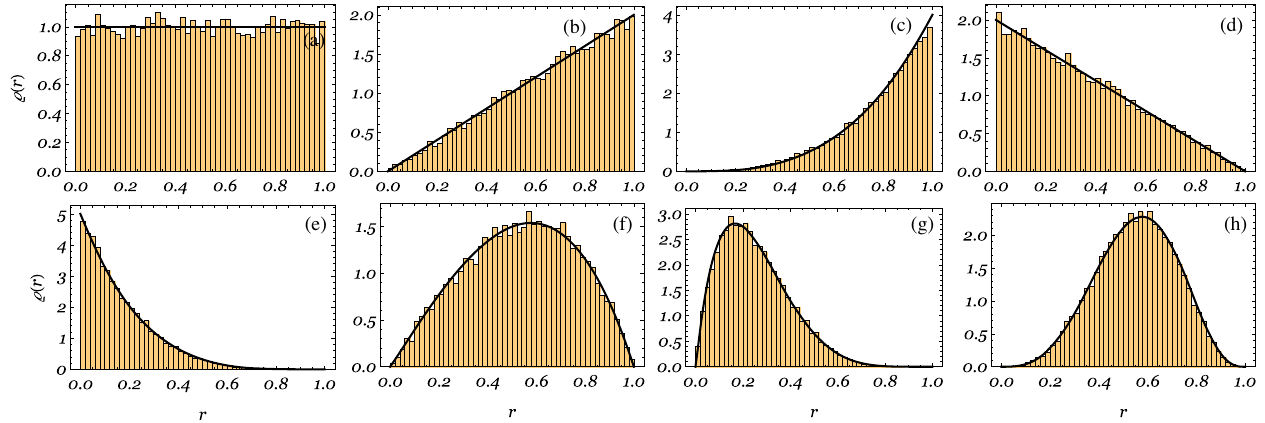
FIG. 12. Comparison of analytic prediction for the m NN by k NN spacing ratio, Eq. (A14), black line, with numerical results. Each histogram is obtained by computing the ratios for 20 000 IID levels. The numerical parameters are as follows: (a) d ¼ 1 , m ¼ 1 , k ¼ 2 ; (b) d ¼ 2 , m ¼ 1 , k ¼ 2 ; (c) d ¼ 4 , m ¼ 1 , k ¼ 2 ; (d) d ¼ 1 , m ¼ 1 , k ¼ 3 ; (e) d ¼ 1 , m ¼ 1 , k ¼ 6 ; (f) d ¼ 2 , m ¼ 1 , k ¼ 3 ; (g) d ¼ 1 , m ¼ 2 , k ¼ 8 ; (h) d ¼ 2 , m ¼ 2 , k ¼ 6 . Panels (a) – (c) correspond to the NN-by-NNN spacing ratio, Eq. (4), for real, complex, and quaternionic spectra,